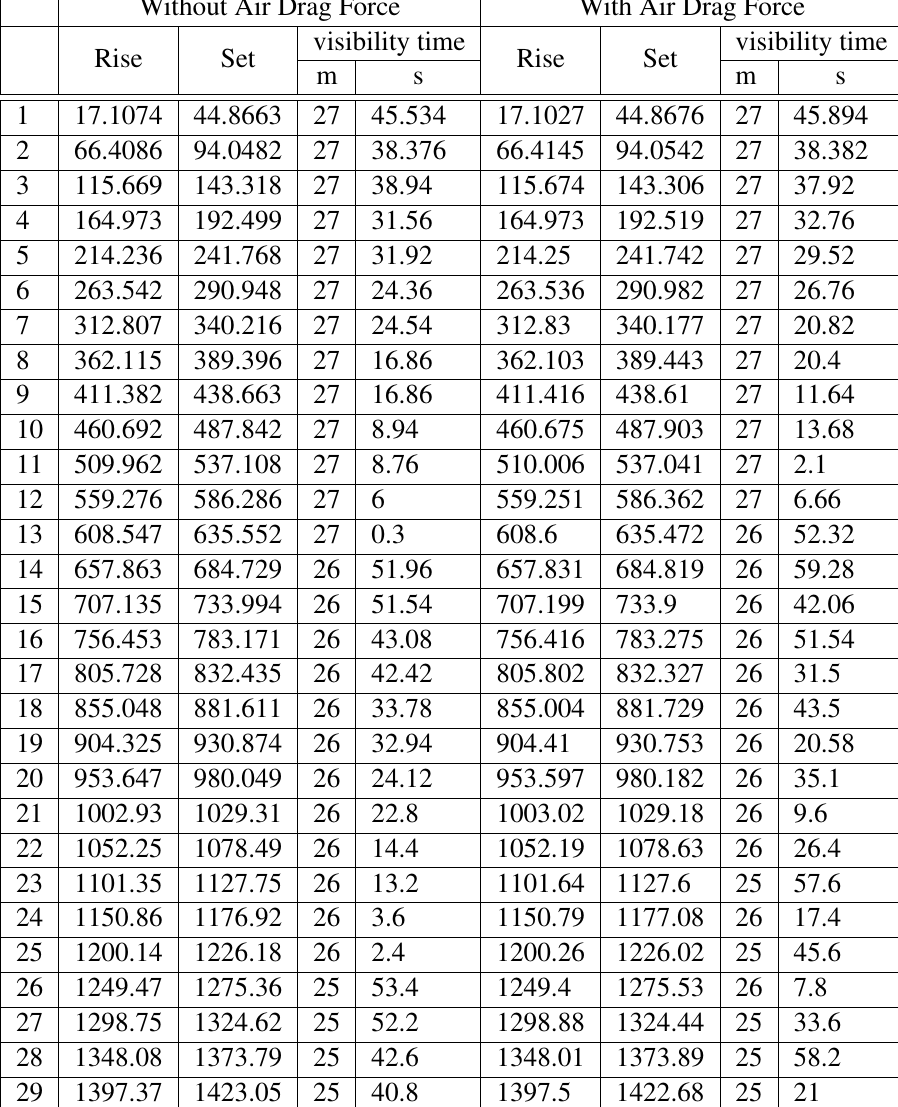
Table 3 Visibility Intervals Between AQUA And ARIRANG2 During 24